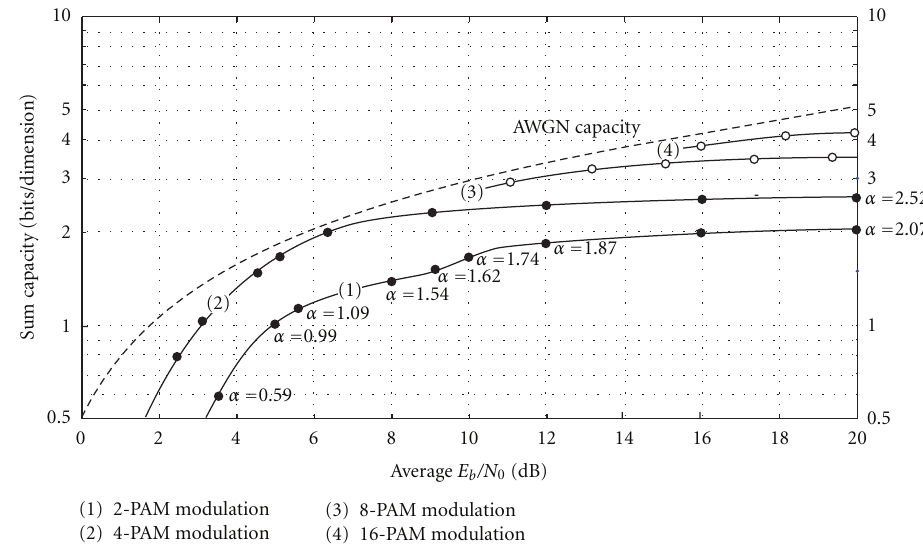
Figure 4: Achievable spectral e ffi ciencies using iterative demodulation of various PAM